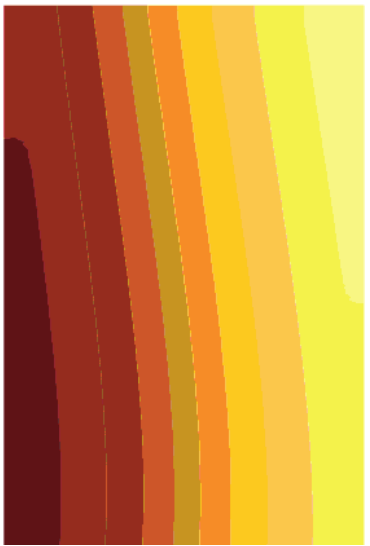
Fig. 6. A digital model was received from smooth TIN